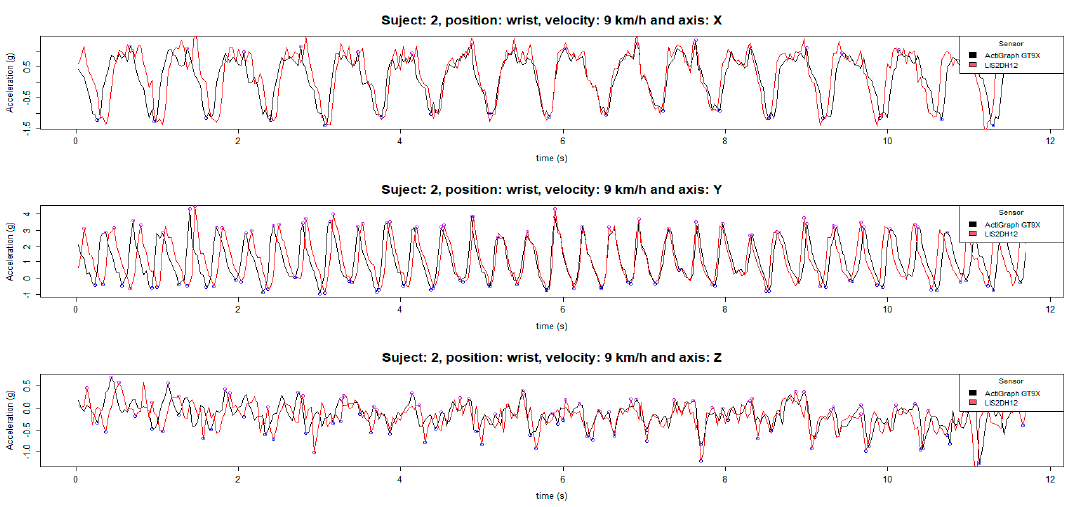
Figure 2. Data sensors ActiGraph GT9X Link and LIS2H12 x-axis, y-axis and z-axis at 9 km/h on the wrist.